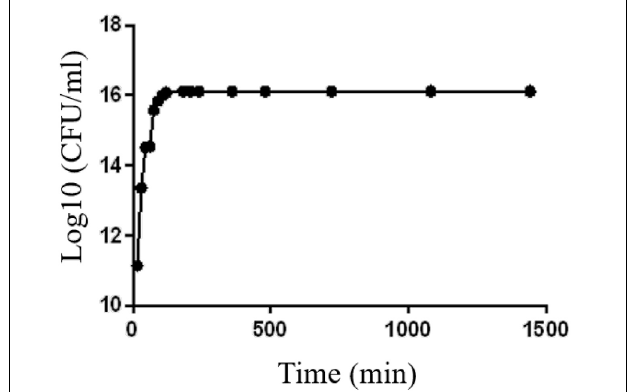
FIGURE 2 | Growth curve of MRSA grown at 37 ◦ C in LB for 24